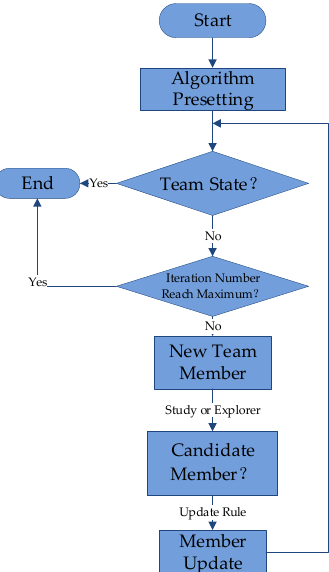
Figure 3. The optimization procedure based on the team progress algorithm (TPA).